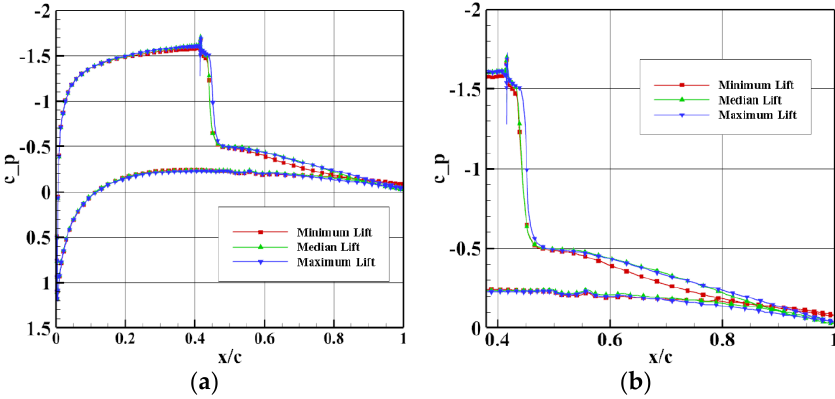
Figure 20. Pressure distributions over the airfoil for the “41% x/c” case at an incidence angle of 6.0°. ( a ) Surface pressure distribution; ( b ) zoomed version.